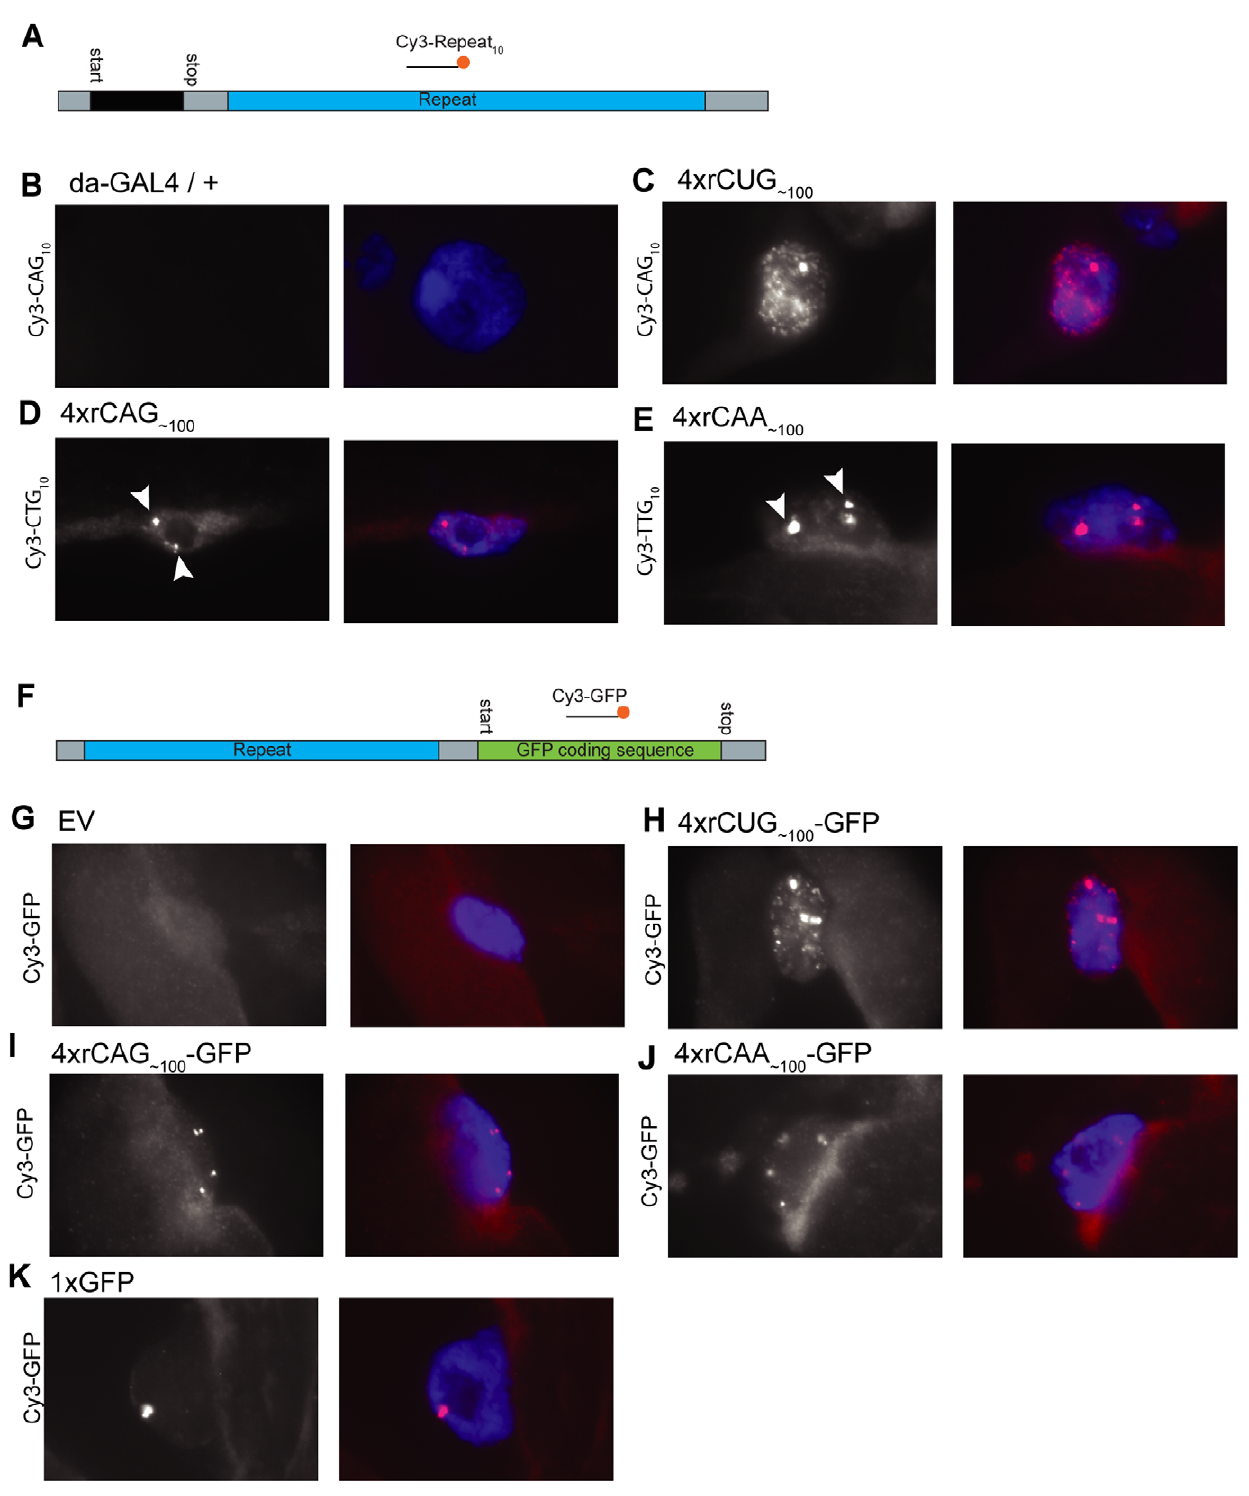
Figure 5. Ubiquitous CUG and CAG RNA repeat expression leads to distinct localisation in muscle nuclei. Images from cryosections hybridised with fluorescent probes to detect repeat RNA. Images are representative of observations from multiple animals and independent transgenic lines for each repeat. A , Schematic of the repeat expression construct, indicating the location of the repeat and probe. B-E , Repeat transcripts detected with a complementary repeat probe. B , Progeny carrying the da-GAL4 driver alone show no signal in the nucleus. C , Expression of 4xrCUG , 100 [line 2] leads to multiple foci throughout the nucleus. D, E , Expression of 4xrCAG , 100 [line 1] , or 4xrCAA , 100 [line 1] leads to between one and four sites of RNA concentration (arrowheads). F , Schematic of the construct giving repeat expression within the context of the GFP transcript, in this case RNA is detected using a probe against the GFP sequence. G-K , Repeat RNA localisation when expressed within a GFP transcript. G , No signal is observed using the GFP complementary probe against control EV progeny. H , 4xrCUG , 100 -GFP expression leads to a similar pattern of